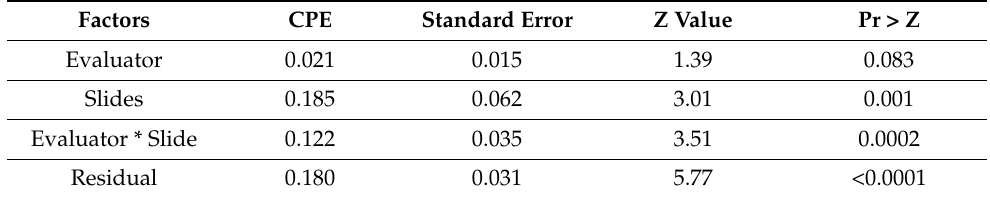
Table 4. Covariance parameter estimate (CPE) for subject and